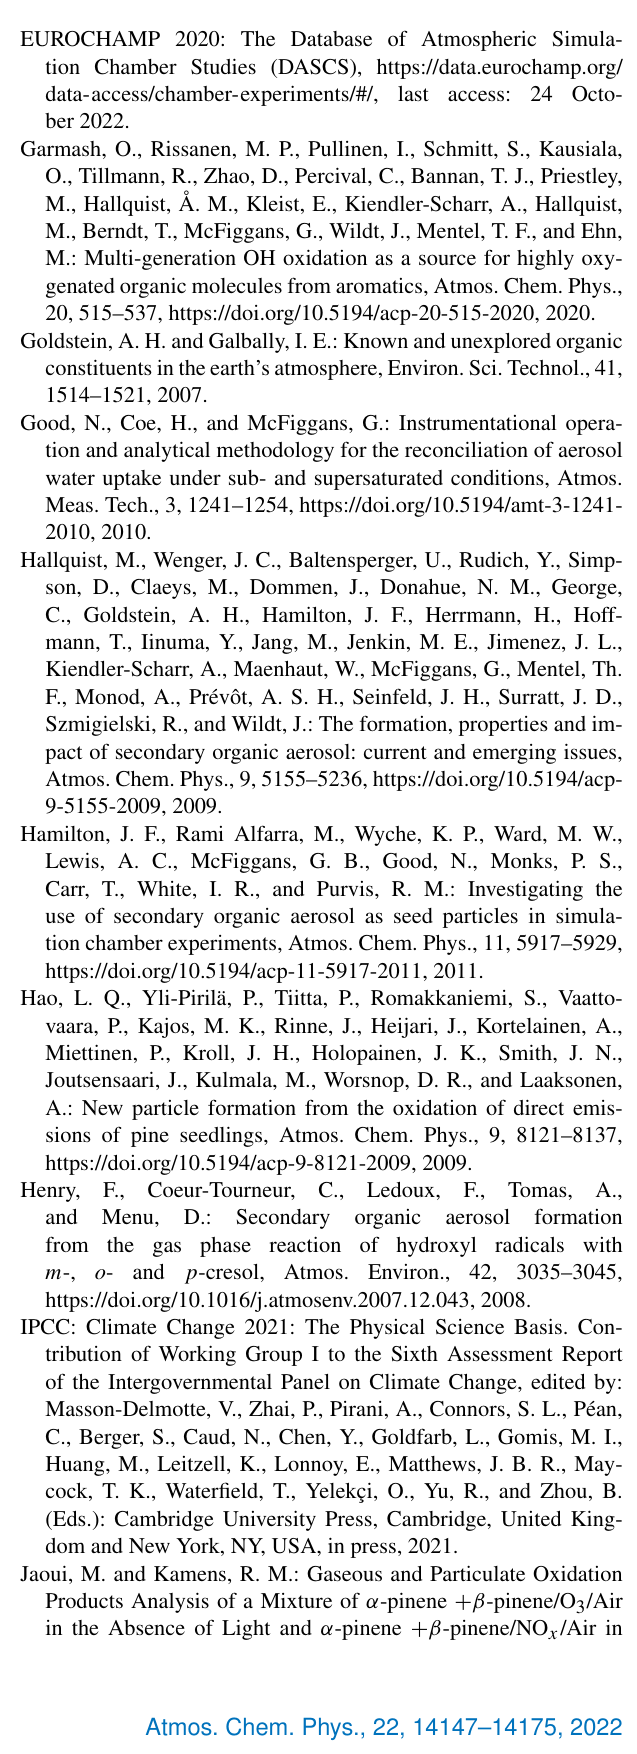
Figgans, G.: Combined application of online FIGAERO-CIMS and offline LC-Orbitrap mass spectrometry (MS) to characterize the chemical composition of secondary organic aerosol (SOA)